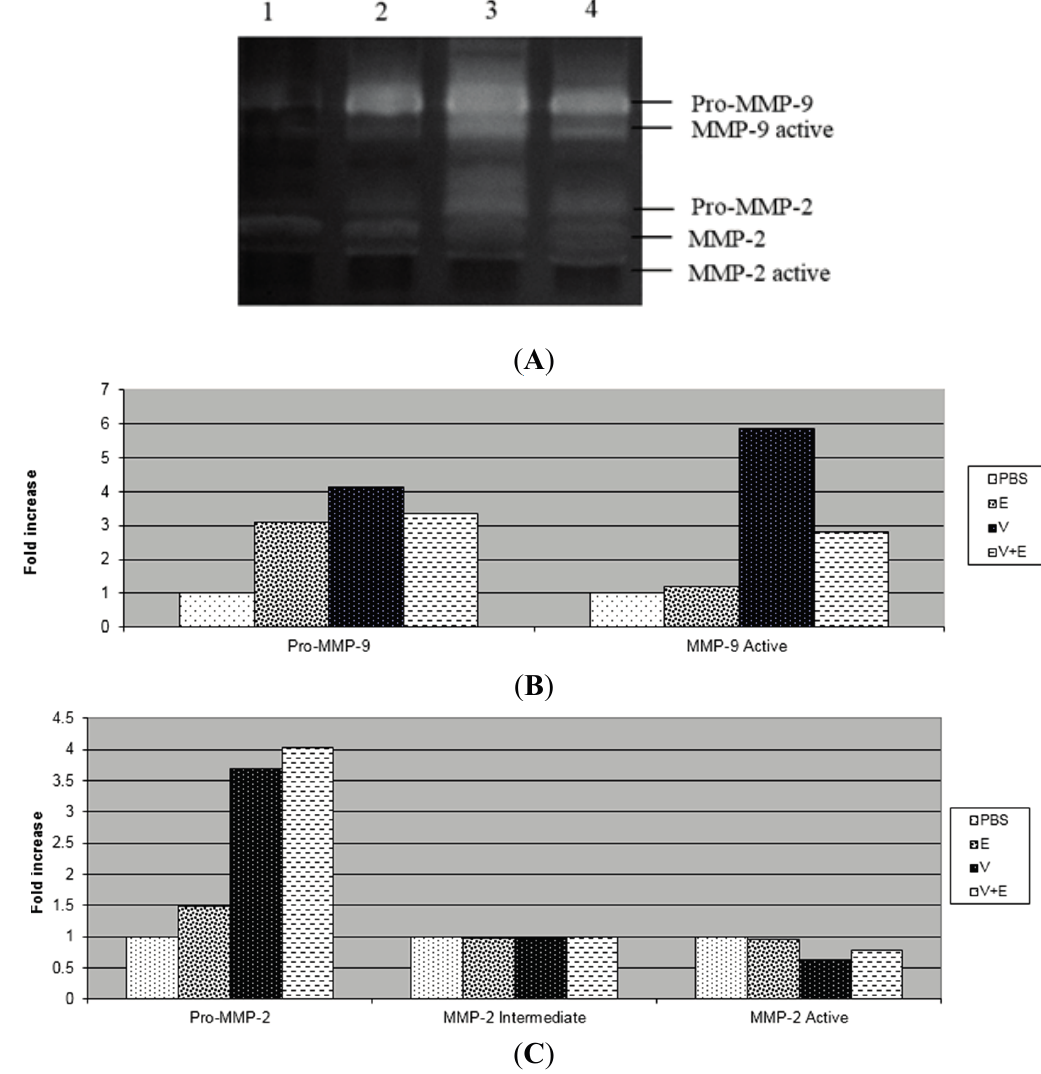
Figure 2. Effect of the methanolic extract from Davilla elliptica on the gelatinolytic activity of MMP-9 and MMP-2 in mouse dermis. ( A ) Gelatinolytic activity of MMP-2 and MMP-9: PBS (lane 1); Methanolic extract (E) (lane 2); venom (V) (lane 3); venom + methanolic extract (V + E) (lane 4); ( B ) The gelatinolytic activity of MMP-9 by integrated optical density (IOD); ( C ) The gelatinolytic activity of MMP-2 by integrated optical density (IOD). The results are presented as fold